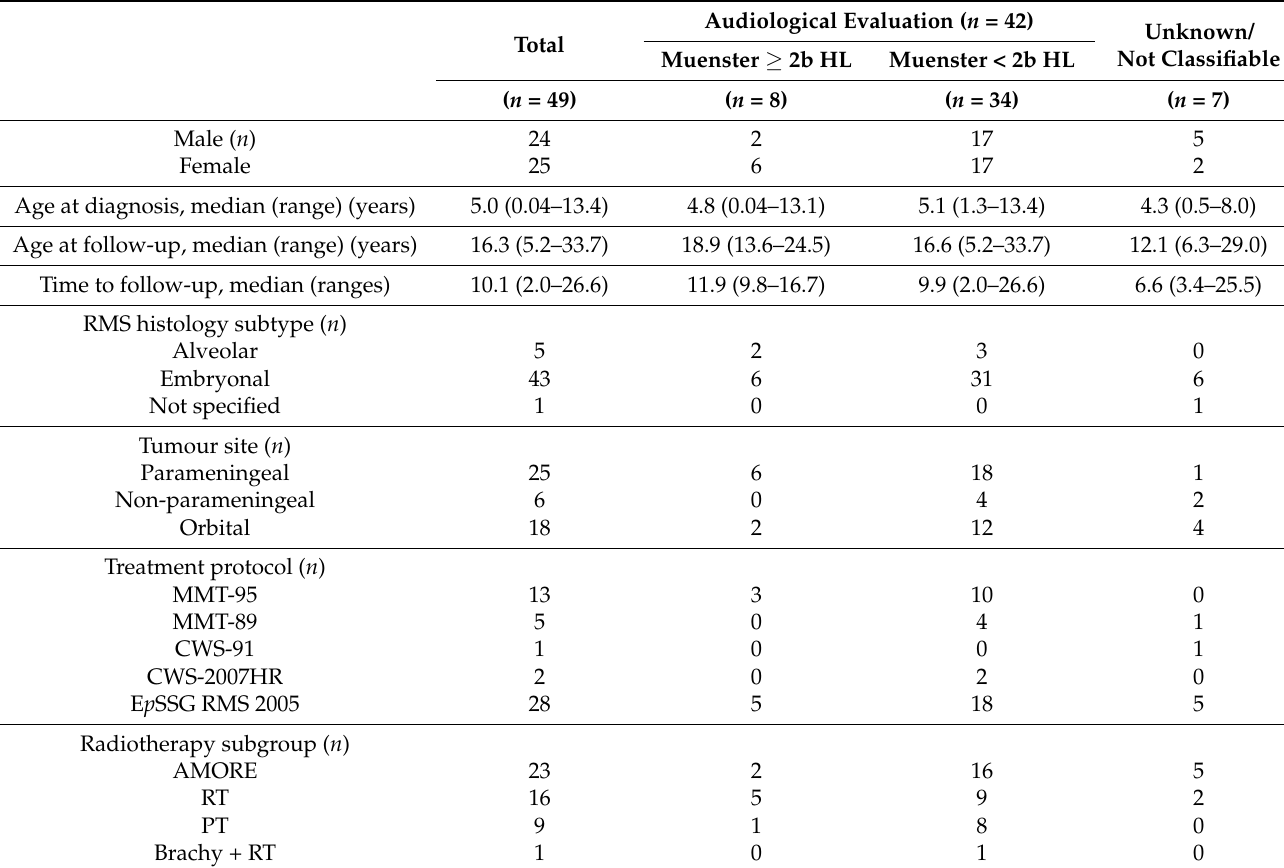
Table 2. Clinical characteristics of patients with